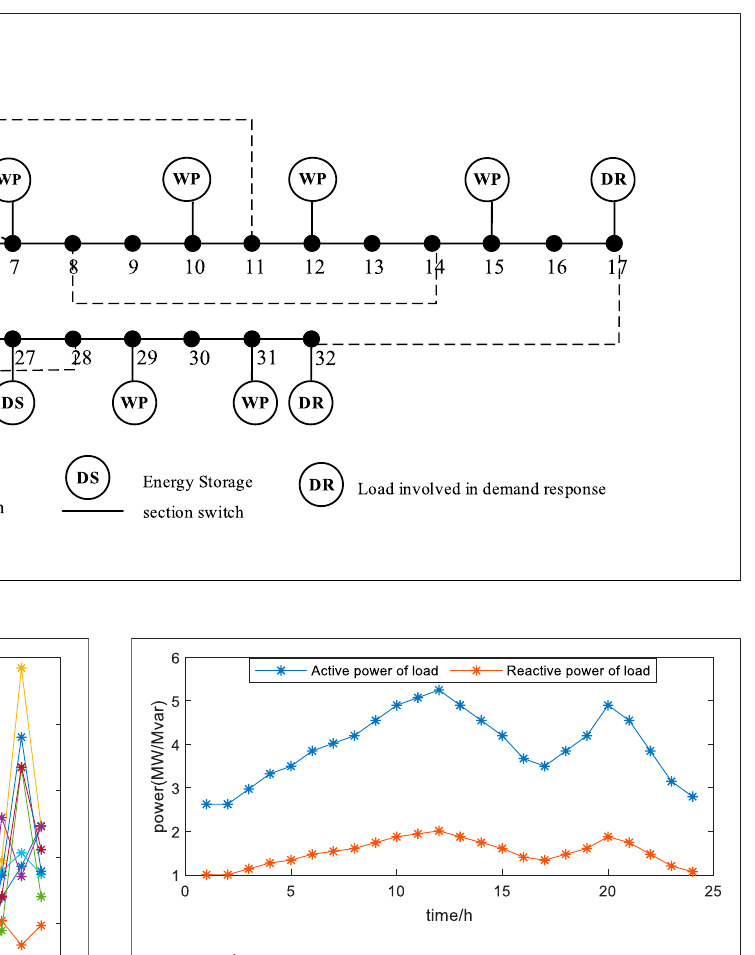
FIGURE 3 | Total load of the distribution network before